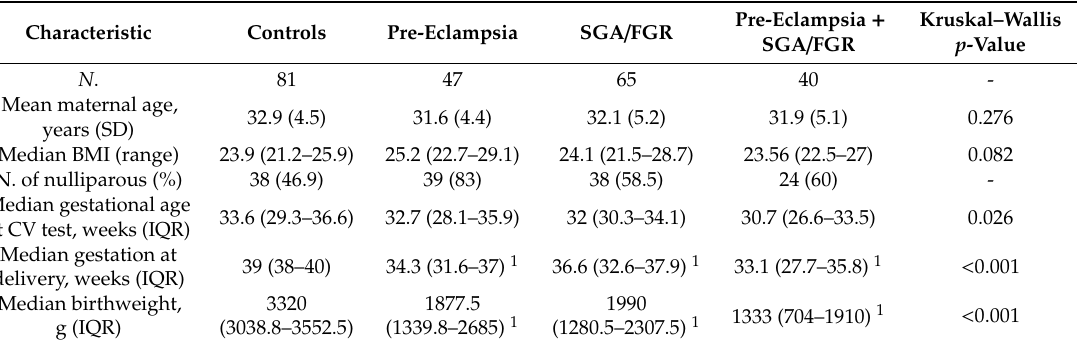
Table 1. Demographic characteristics of study participants .